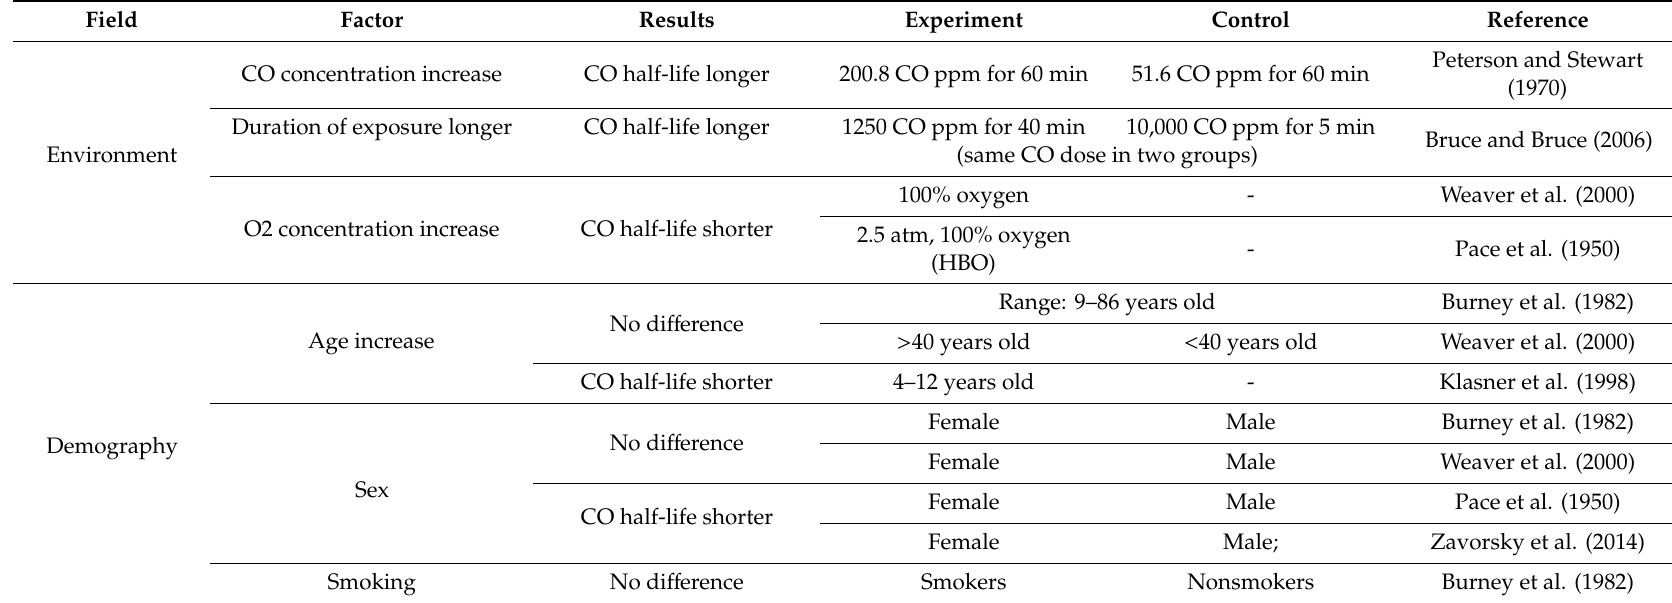
Table 2. The factors related to CO